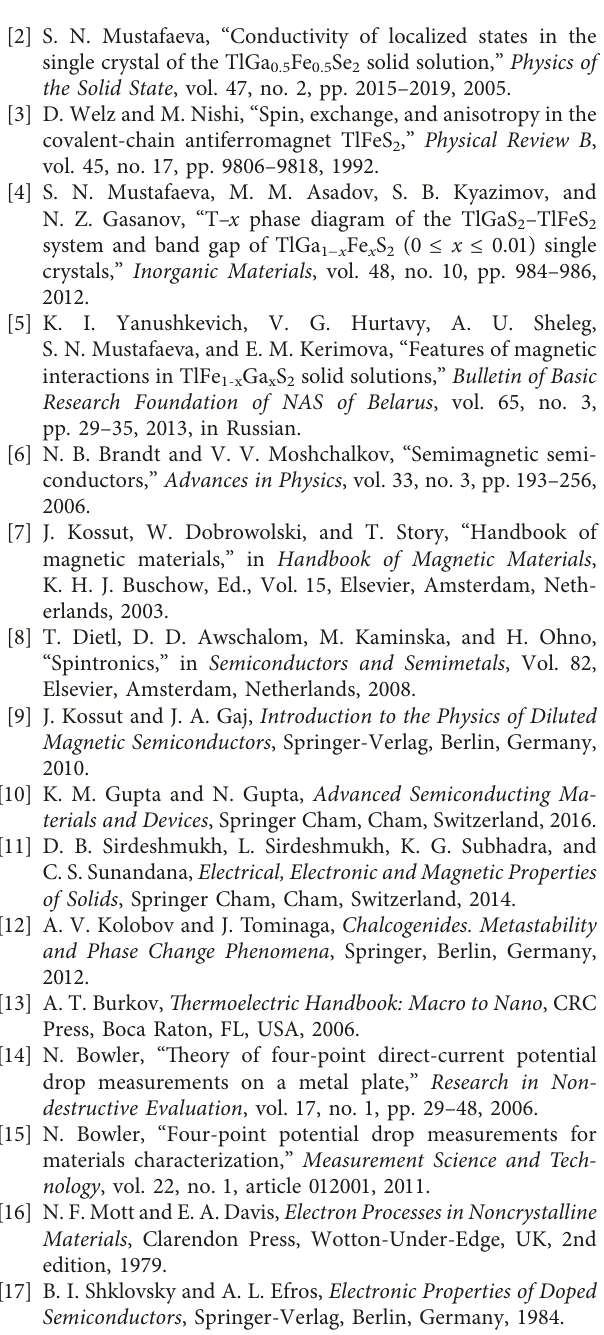
Table 2: Parameters of localized states in TlFe